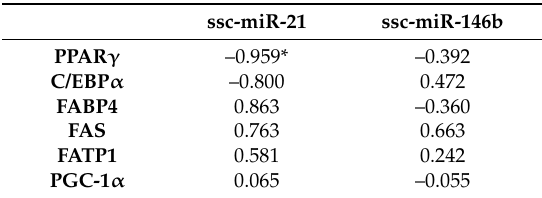
Table 3. Correlations between miRNAs and adipogenic transcription factors or adipocyte genes in pigs with CLA.